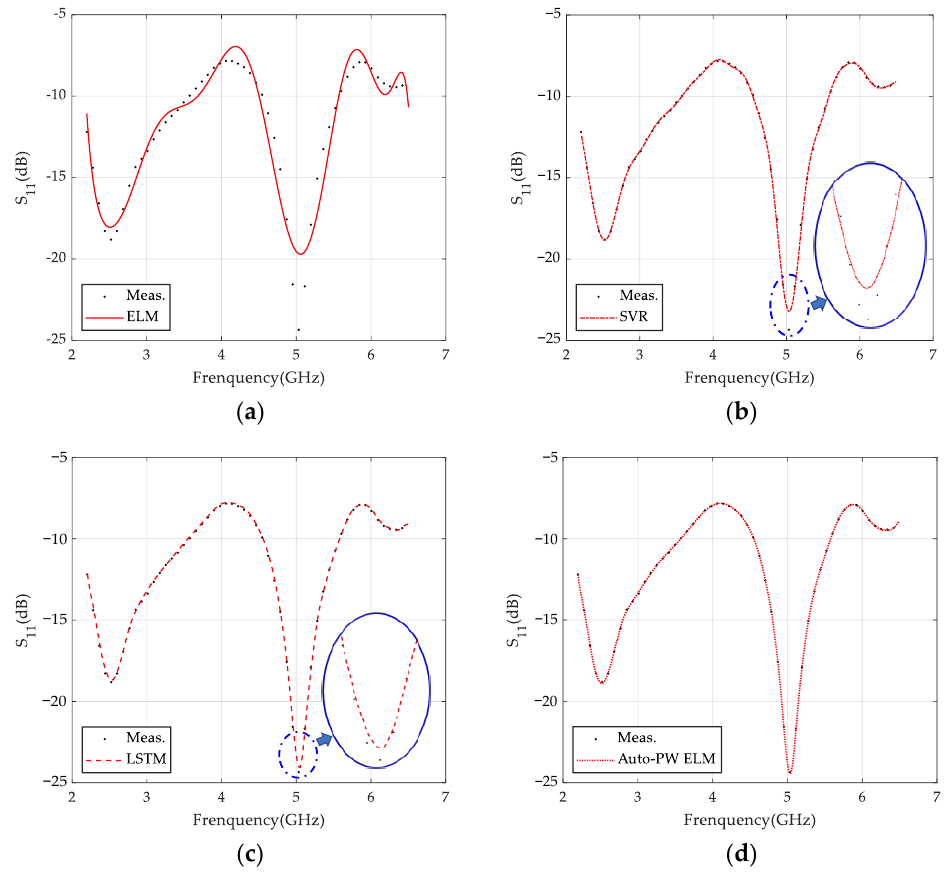
Figure 6. Modeling results of S 11 parameters. ( a ) Comparison of ELM model and measured data. ( b ) Comparison of SVR model and estimated data. ( c ) Comparison of LSTM model and measured data. ( d ) Comparison of automatic piecewise ELM model and measured data.